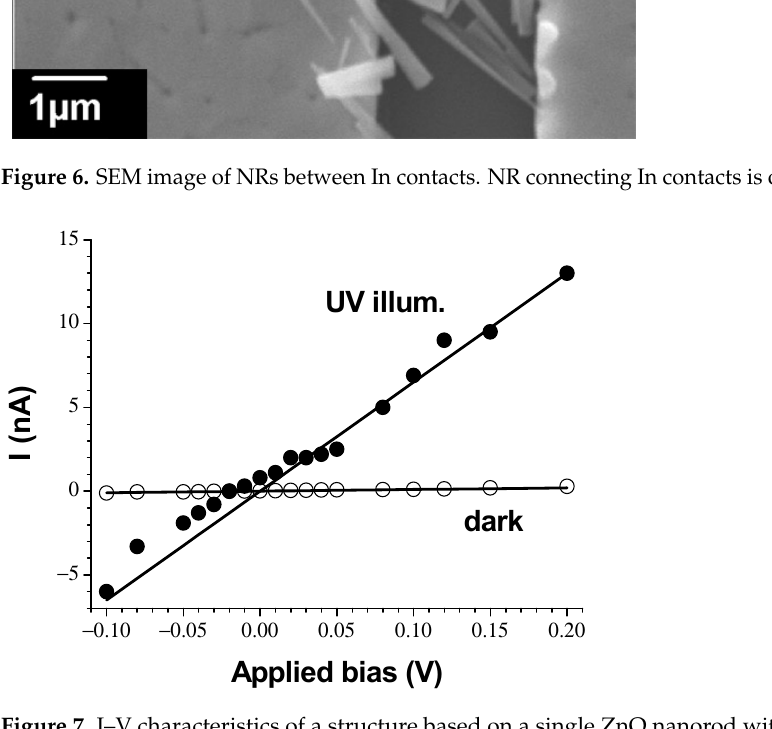
Figure 7. I–V characteristics of a structure based on a single ZnO nanorod with indium contacts in the dark and under UV light.